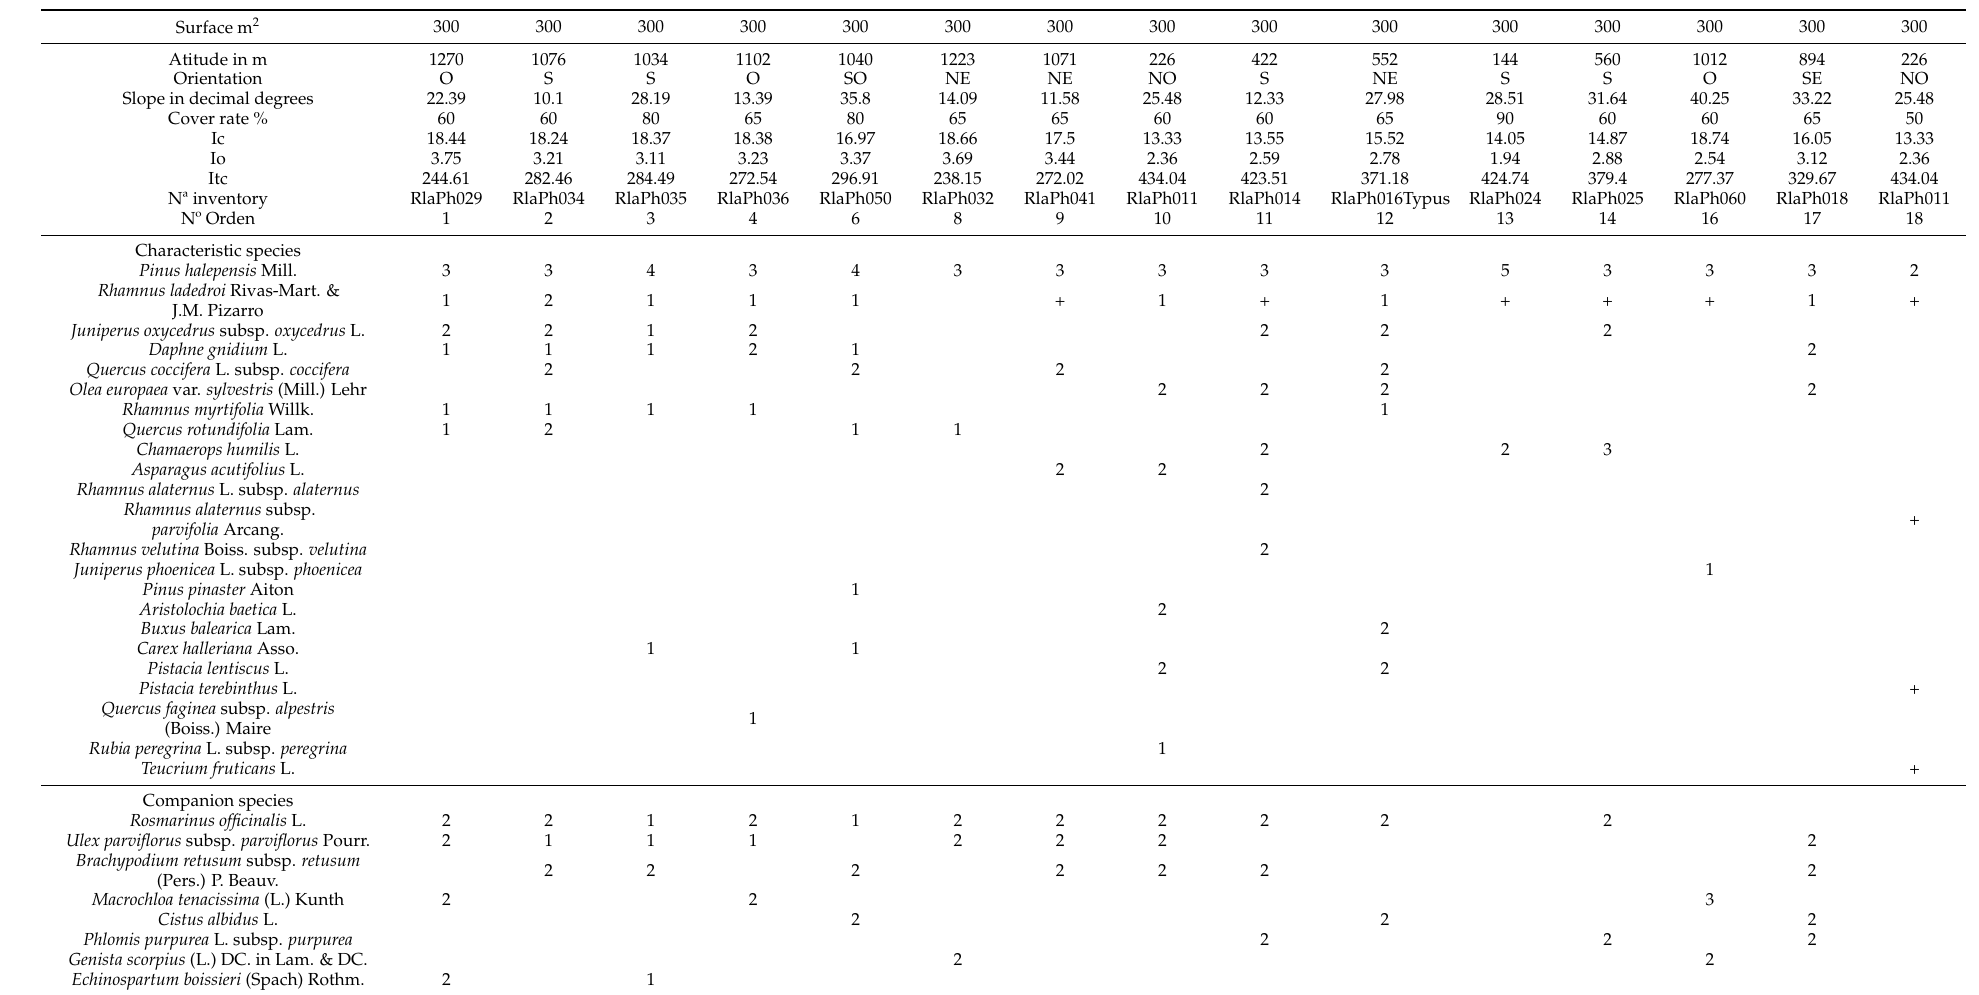
Table A4. Rhamno laderoi-Pinetum